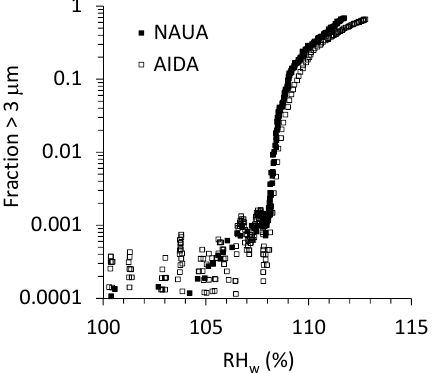
Figure B2. As in Fig. 2, raw 1Hz CFDC data from an ICIS- 2007 experiment on 24 September 2007 showing the fraction of total aerosol concentrations (measured by a condensation particle counter) appearing at optical particle counter sizes above 3µm dur- ing RH w scanning for two experiments at − 21 ◦ C when processing particles from a dust sample that had been collected following a dust storm in Israel (Kanji et al., 2011). The data termed NAUA were sampled following dispersion into a 4m 3 aerosol chamber, with concentrations of approximately 5000cm − 3 present at the time of sampling. The data termed AIDA were sampled directly from the AIDA expansion chamber prior to a cloud expansion, when the total particle concentrations were approximately 100cm − 3 . Wa- ter droplet breakthrough of the CFDC evaporation region occurs at ∼ 108% in each case, and progressively more activated cloud droplets survive through the evaporation region as RH w is increased